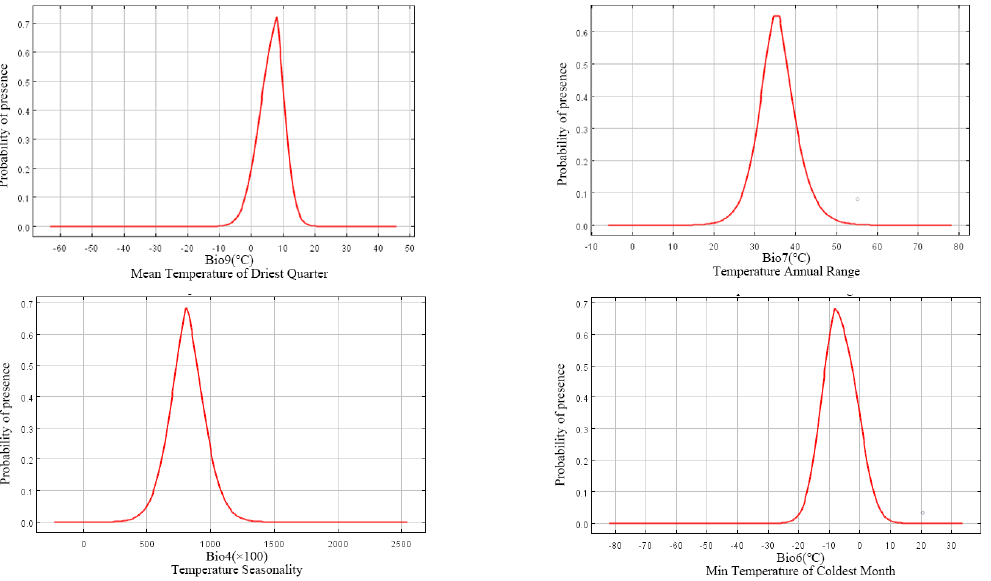
Figure 3. Response curves for important environmental predictors in the species distribution model for Liriodendron chinense ( A ) and Liriodendron tulipifera ( B ). According to the influence curves of five variable factors of L. tulipifera (Figure